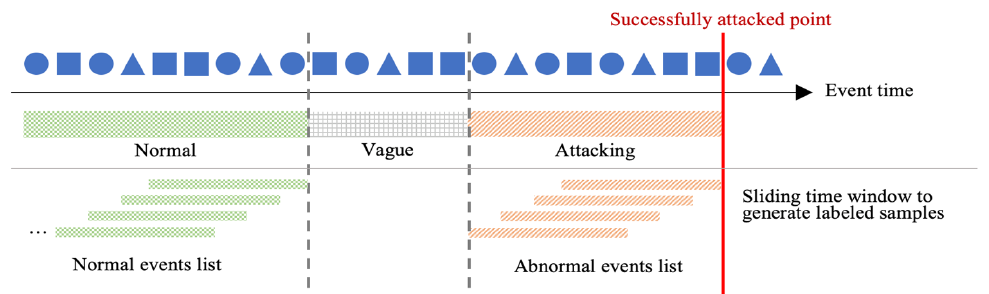
Figure 5. Schematic representation of the data resampling method: The interval between normal events and abnormal events is (Vague) 10 min. The abnormal events (Attacking) time length is 20 min. The resampling window length is 10 min, and the sliding step is 1 min.